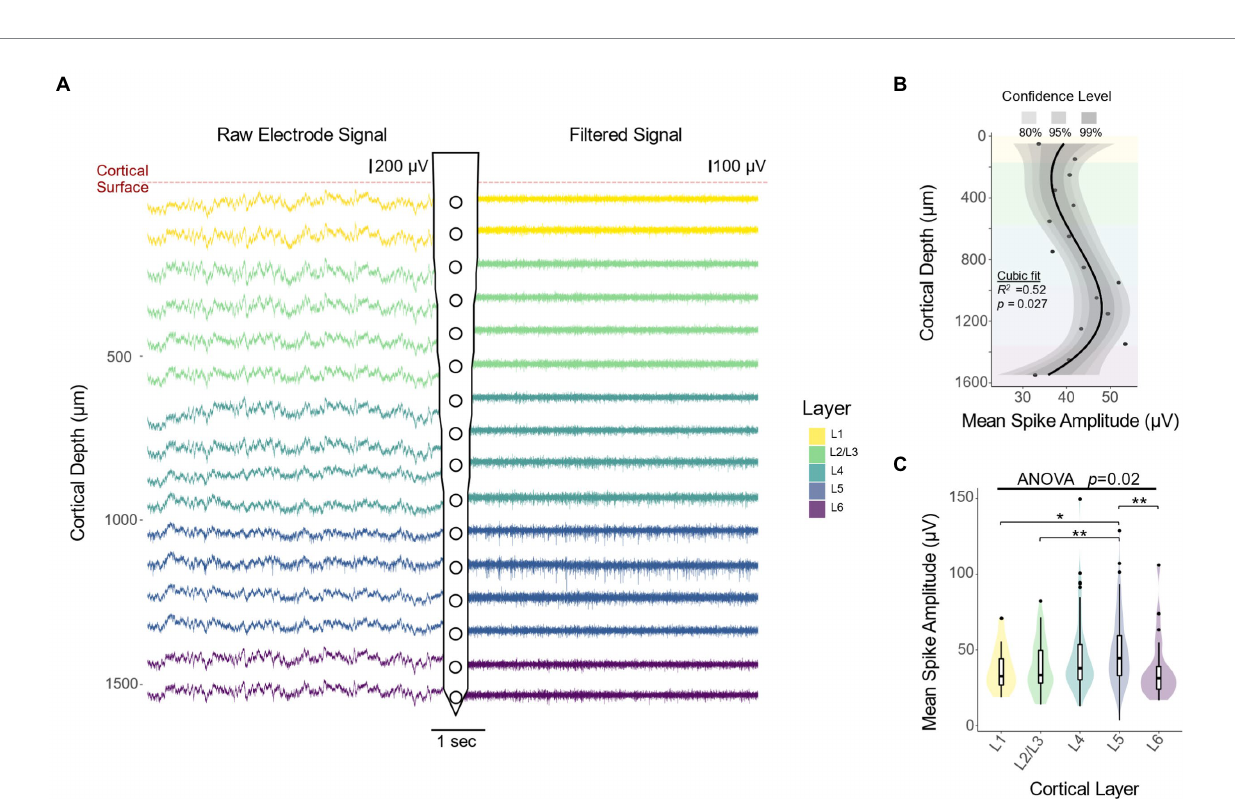
FIGURE 2 Extracellular recordings across cortical depth. (A) Representative raw and filtered recording traces from electrode sites at different cortical depths. Compared to superficial channels, electrode sites located near L4 and L5 contain more high amplitude downward deflections, characteristic of action potentials. (B) Mean spike amplitude over depth during the first 2 weeks of implantation reveals an increase in spike amplitude with cortical depth, reaching a maximum approximately 1,100 μ m from the cortical surface ( N = 6). The black line represents a locally fitted polynomial regression of the means and shaded areas represent confidence intervals. (C) Quantification of spike amplitude across cortical layers (one-way ANOVA followed by Dunn–Bonferroni’s correction) and pairwise comparisons between layers (two-tailed t -test followed by Dunn–Bonferroni’s correction). * p ≤ 0.05, ** p ≤